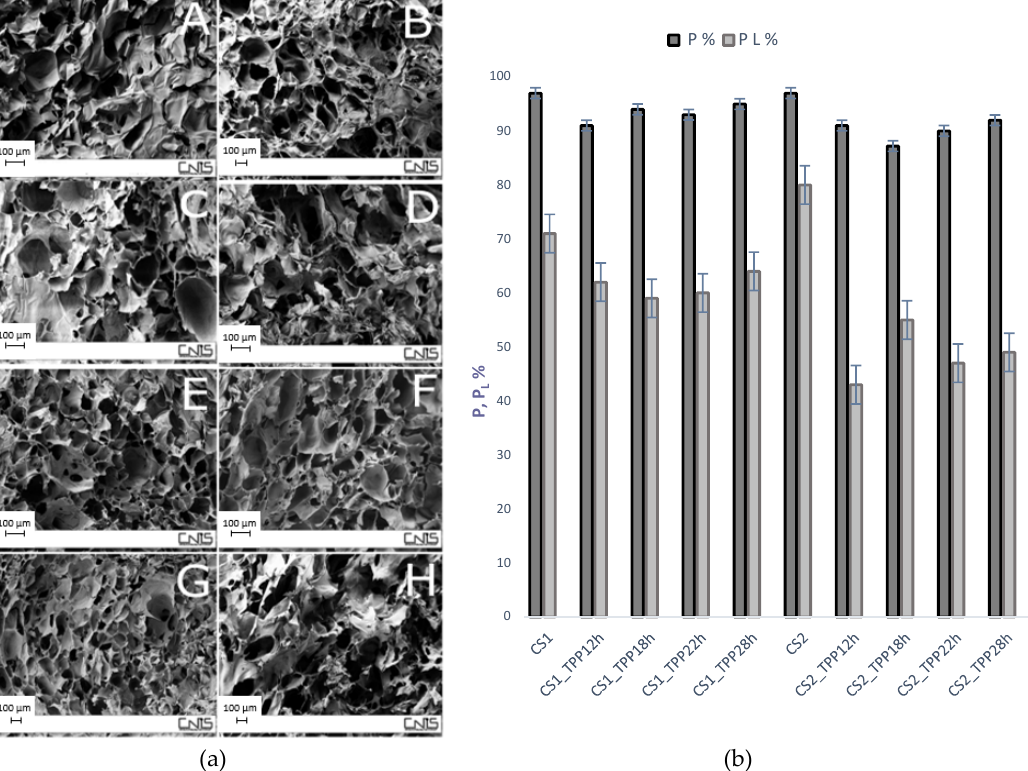
Figure 6. ( a ): Scanning Electron Microscopy (SEM) micrographs of the obtained scaffolds: pristine CS1 (A) and CS2 (B); CS1_TPP1 2h (C) and CS1_TPP1 8h (D); CS1_TPP2 2h (E) and CS1_TPP2 8h (F); and CS2_TPP2 2h (G) and CS2_TPP2 8h (H). ( b ): Total porosity (P%) and interconnected porosity (P L %) of